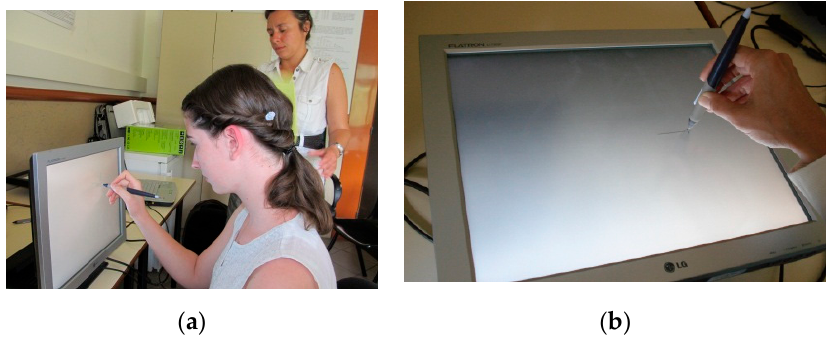
Figure 1. Lineograms test: in frontal movement type ( a ) and in transversal movement type ( b ).